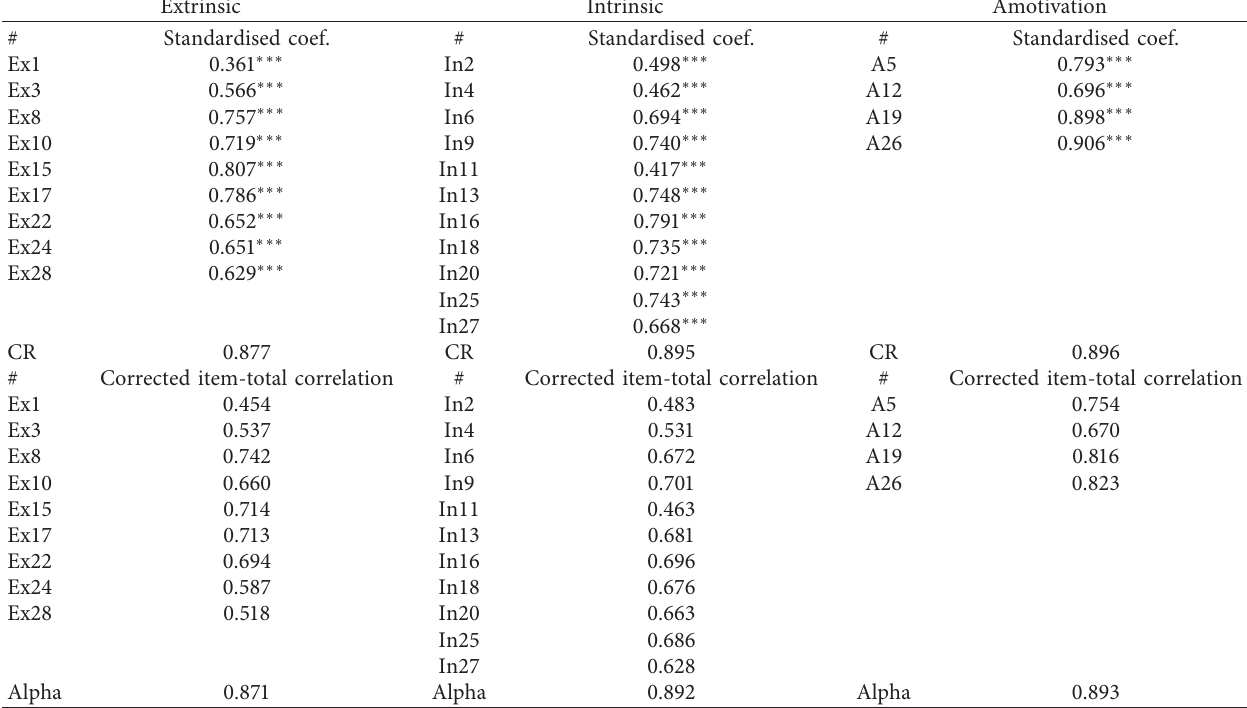
Table 6: Items loaded on latent variables